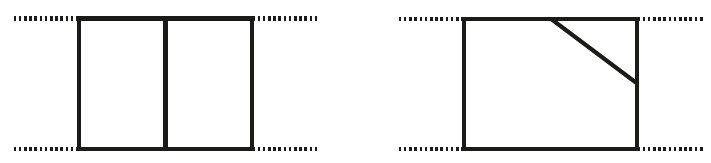
Figure 3 . The two-loop integral families which appear in expansion approach (B). The solid lines have mass m t and the dotted external legs are massless. Variations of these families with permutations of the external legs also